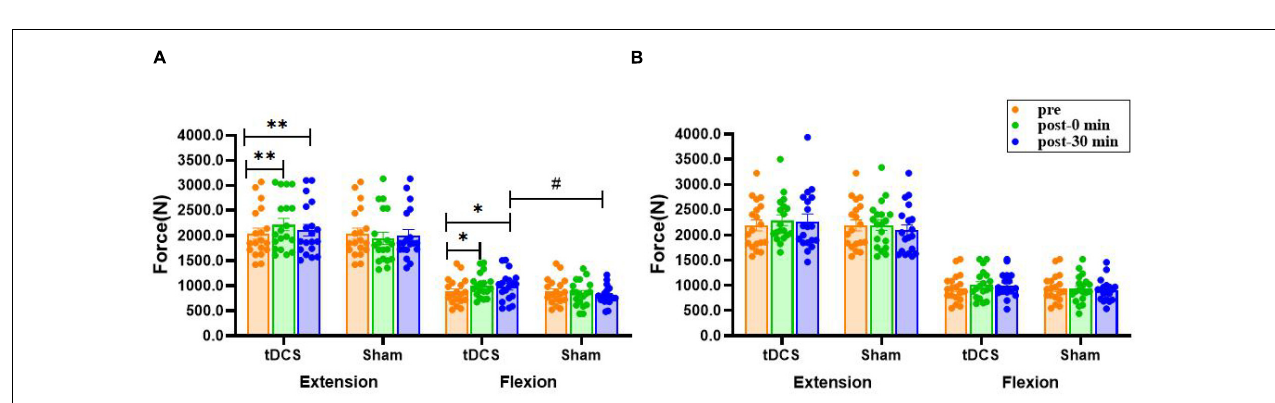
FIGURE 3 | Effects of tDCS on rate of force development (N · s − 1 ) of left (A) and right (B) knee flexors and extensors. pre: prestimulation, post-0 min: 0 min after stimulation, post-30 min: 30 min after stimulation. Data are presented as mean ± SEM. Asterisks ( ∗ ) indicate statistically significant difference compared to prestimulation ( ∗ P < 0.05, ∗∗ P < 0.01). Well number (#) indicates statistically significant difference compared to sham ( # P < 0.05).